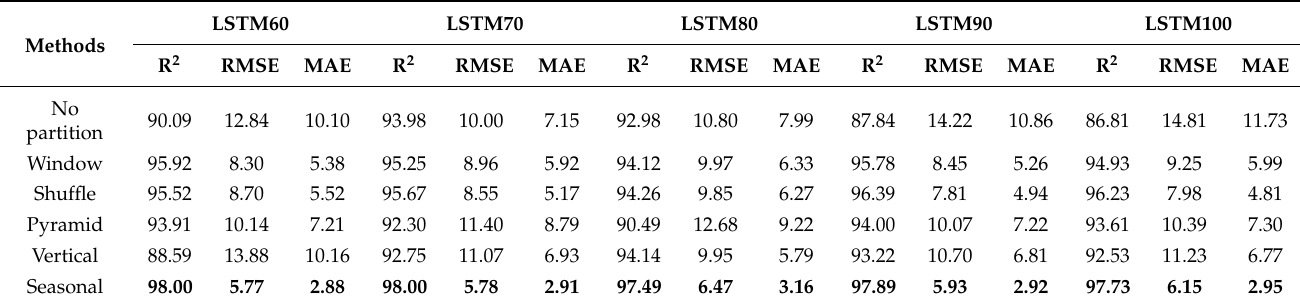
Table 7. Experimental results of daily forecasting of Site A.